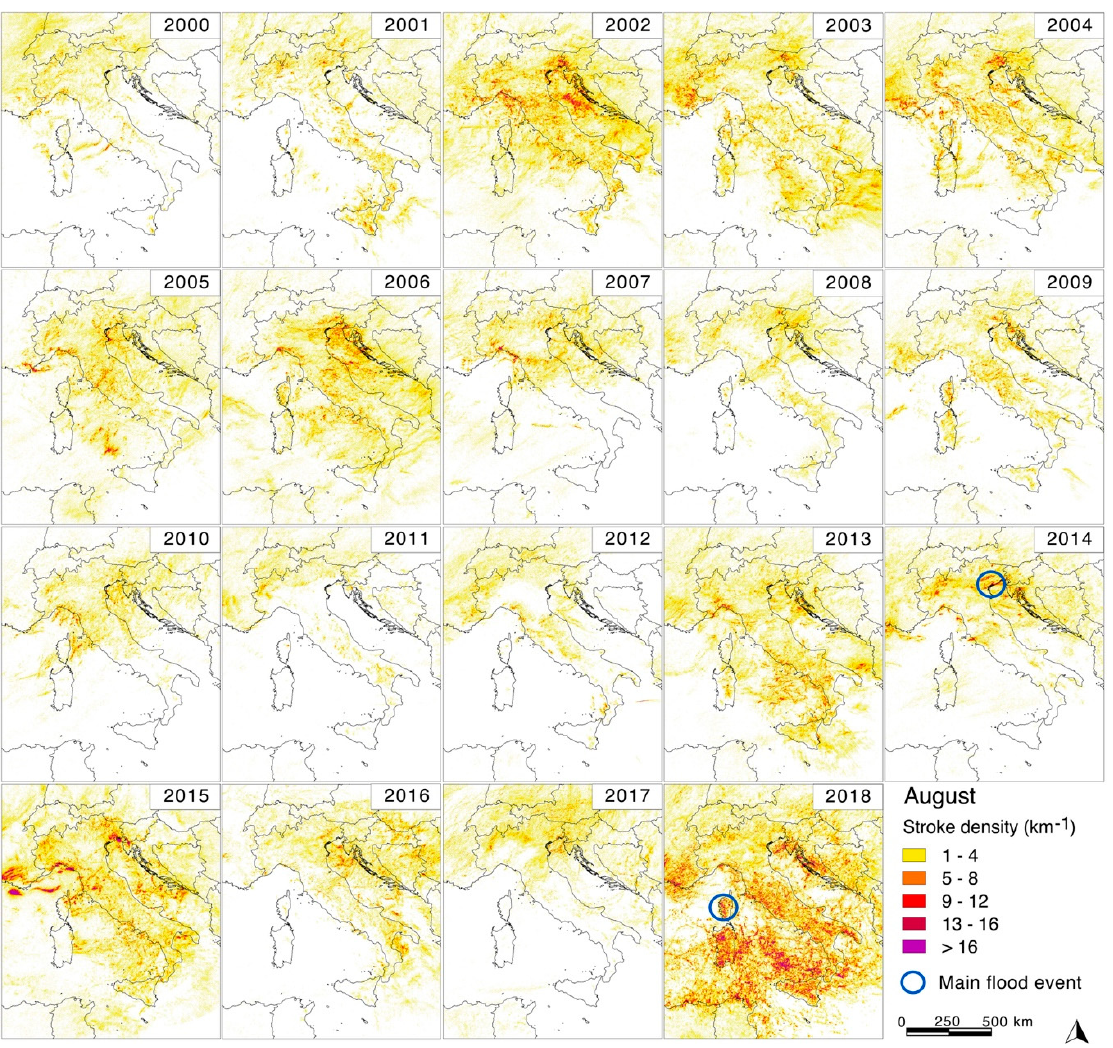
Figure 5. Cloud–ground strokes per square km in August for the entire period. Blue open circles indicate main flood events.